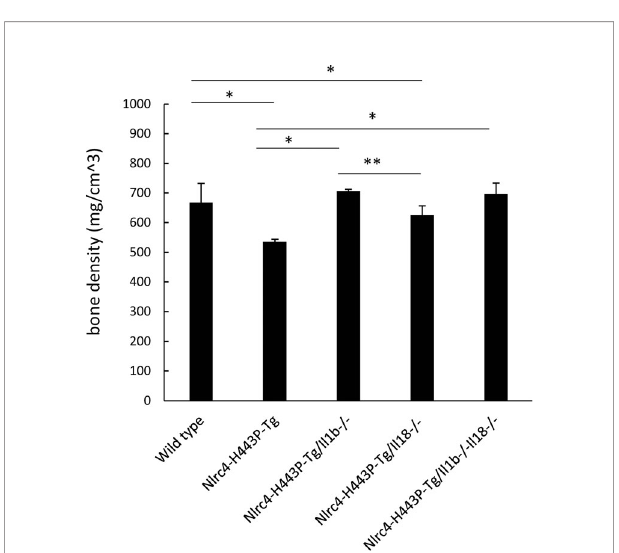
FIGURE 4 | Rescue of decreased bone density by de fi ciency of Il1b or Il18 in Nlrc4-H443P-Tg mice. Bone density in control, Nlrc4-H443P-Tg, Nlrc4- mice at the age of 20 weeks was evaluated with m CT (N = 10 in each group). The data are shown as the mean ± SD. *P < 0.05, **P <